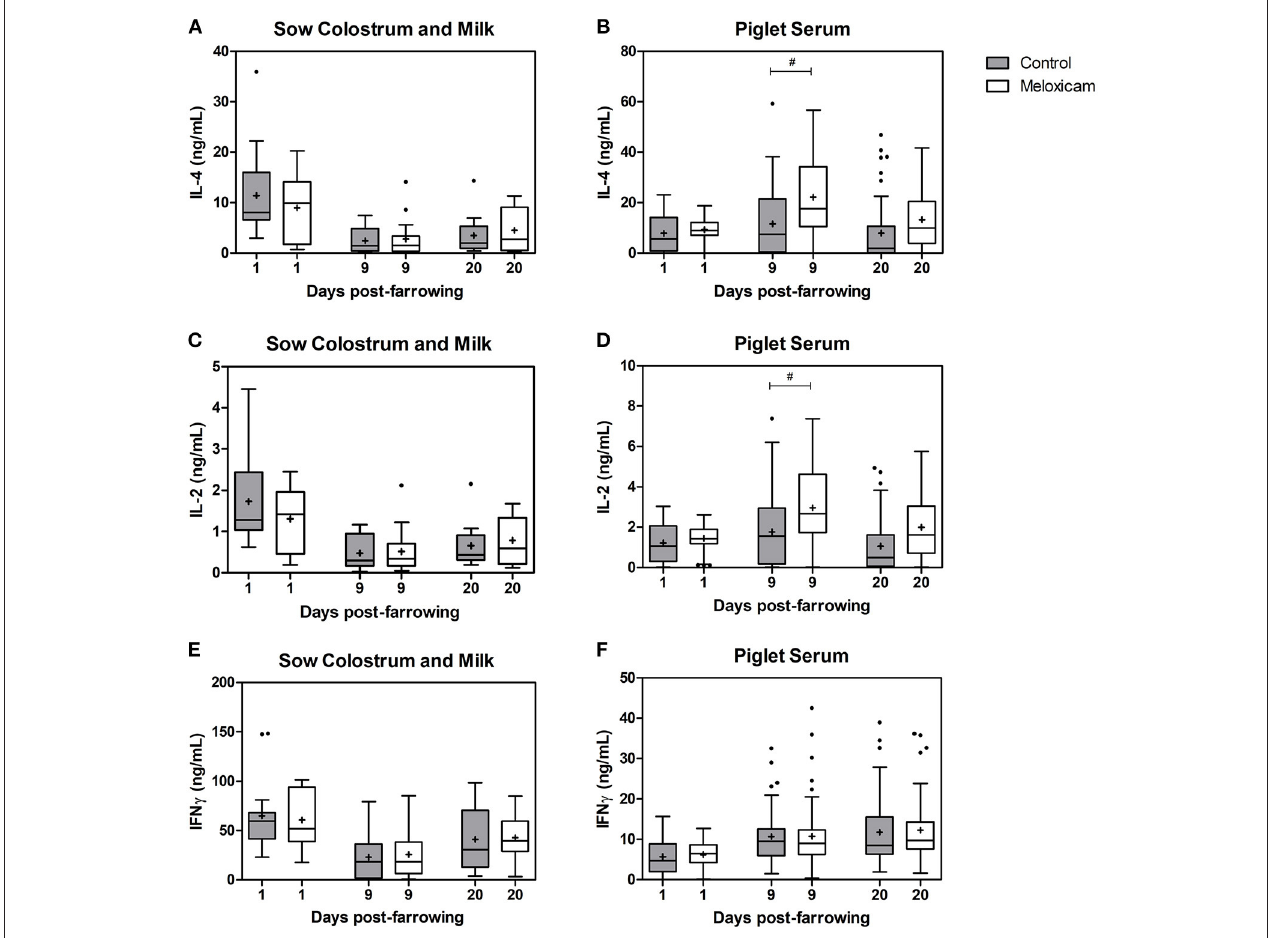
FIGURE 2 | Concentration of IL-4, IL-2, and IFN- g at days + 1, + 9, and + 20 after farrowing regarding treatment received by sows (control vs. oral meloxicam) in sow colostrum and milk (a, c, e) and piglet serum (b, d, f). Tendency differences were established at p < 0.1(#). Boxes represent the interquartile range (IQ = Q3 – Q1), horizontal lines inside the boxes represent the median and the cross (+) represents the mean values of the data. Whisker bars were calculated from the IQ (Upper: Q3 + 1.5 × IQ; lower: Q1 - 1.5 × IQ) and reflect the variability of the data outside Q1 and Q3. Points outside the box-and-whiskers plot represent extreme values of the